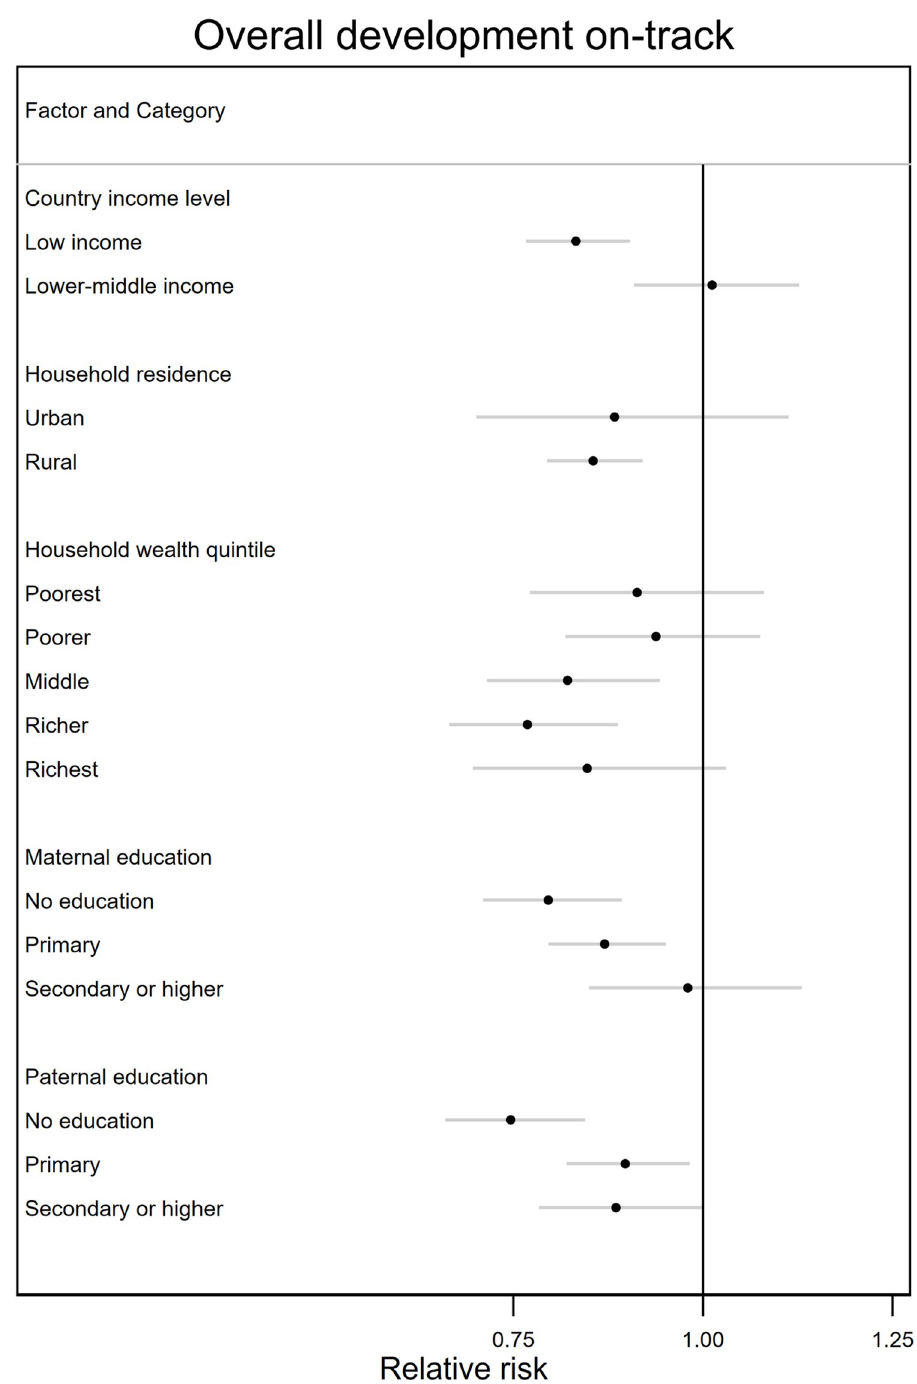
Fig 1. Heterogeneity of the associations between parental occupation and child development by household and parental characteristics, comparing households where both parents were employed in agriculture and households where both parents were employed in non-agriculture. Models adjusted for child age and sex, maternal age and education, paternal age and education, household size, wealth, and location (urban vs. rural), and accounted for representativeness. SEs were clustered at the primary sapling unit